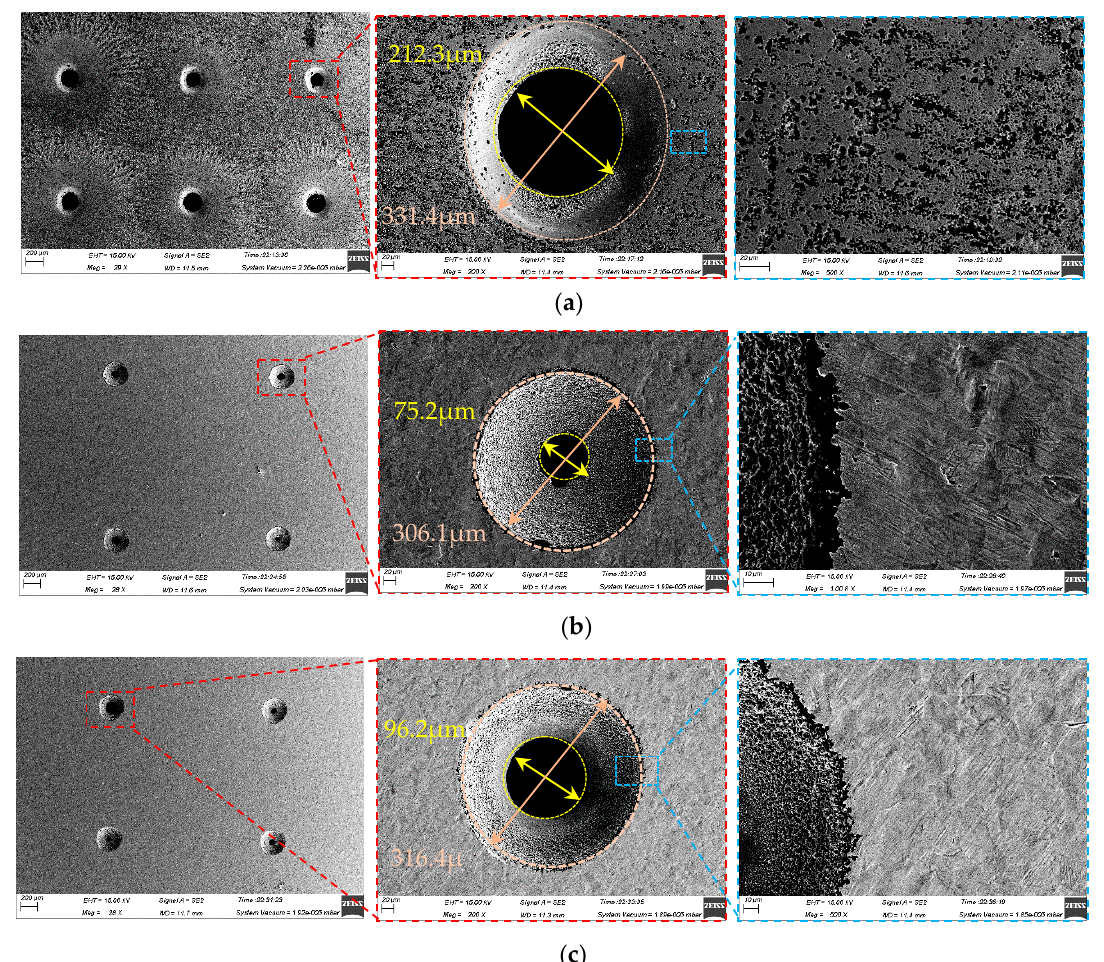
Figure 12. SEM images of the micro-holes machined with different modes when the electrical voltage was 10 V, the nozzle’s inner diameter was 170 µm, and the working gap was 100 µm. ( a ) Vertically downstream mode; ( b ) vertically upstream mode; ( c ) horizontal mode.